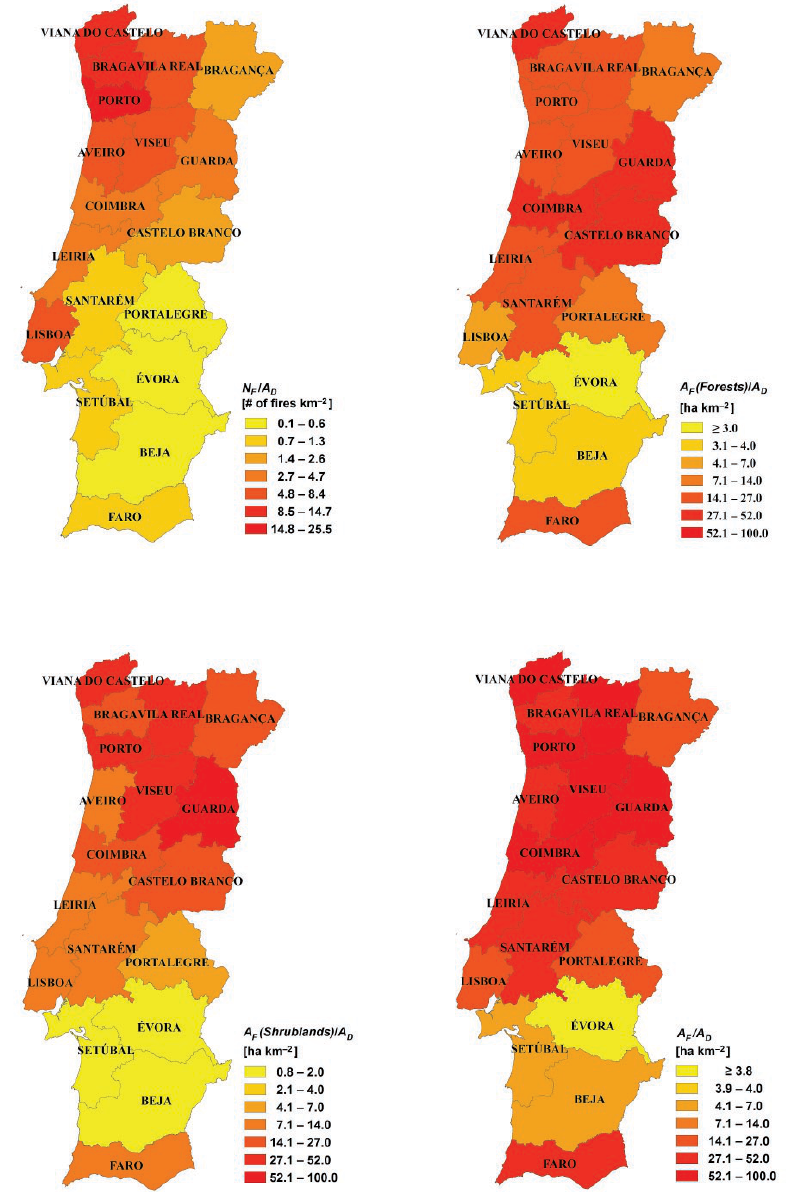
Fig. 7. Fire numbers and burnt areas in Continental Portugal districts normalized by each district’s area, A D (km 2 ). Given in (a) are the normalized number of fire records, N FT /A D (in # of fires perkm 2 ) . In (b) to (d) are given the normalized total burnt areas, A FT / A D (inha perkm 2 ) , with a logarithmically increasing legend, for (b) forests, (c) shrublands, (d) forest plus shrublands. In these analyses, fires included have burnt area A F ≥ 0.1ha and are for the 1980–2005